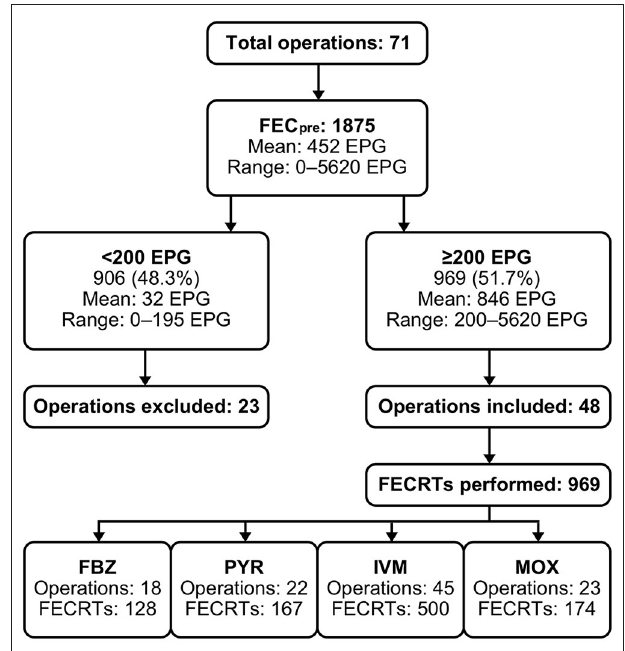
FIGURE 1 | Flow diagram of the study design and FEC pre results represented by EPG prior to the statistical analysis of the FECRTs for FBZ, PYR, IVM and MOX. EPG, eggs per gram; FBZ, fenbendazole; FEC pre , initial pre-treatment fecal egg count; FECRT, fecal egg count reduction test; IVM, ivermectin; MOX, moxidectin; PYR, pyrantel